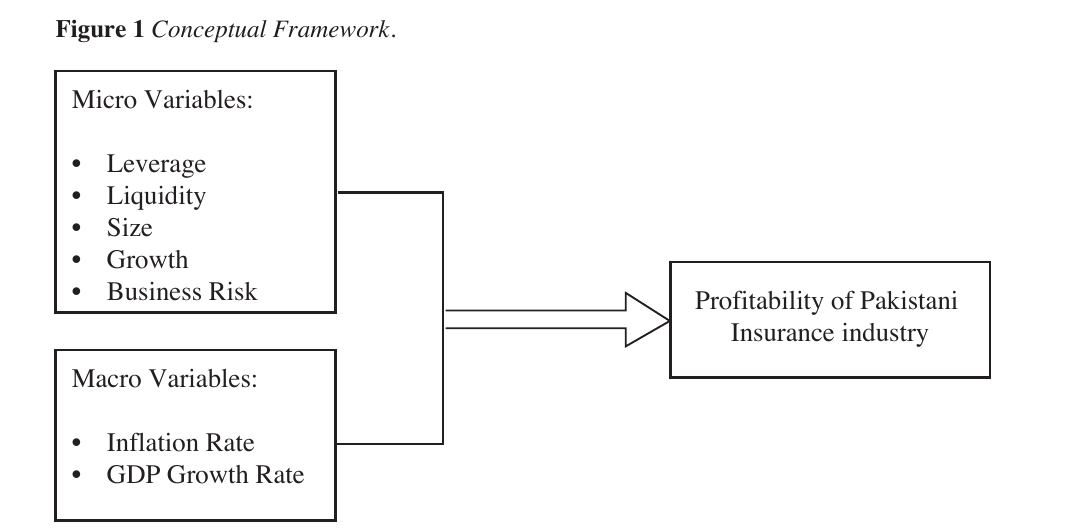
Figure 1 Conceptual